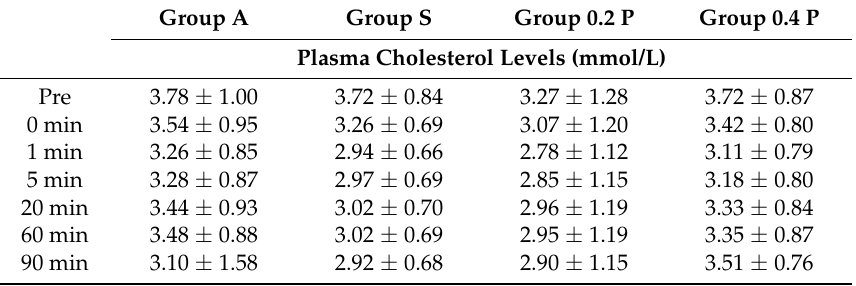
Table 3. Changes in cholesterol concentrations after the glucose challenge. Pre (before anesthesia induction): each time point indicates the elapsed time after the glucose challenge; 0 min means just before the glucose injection. Data are expressed as mean ±